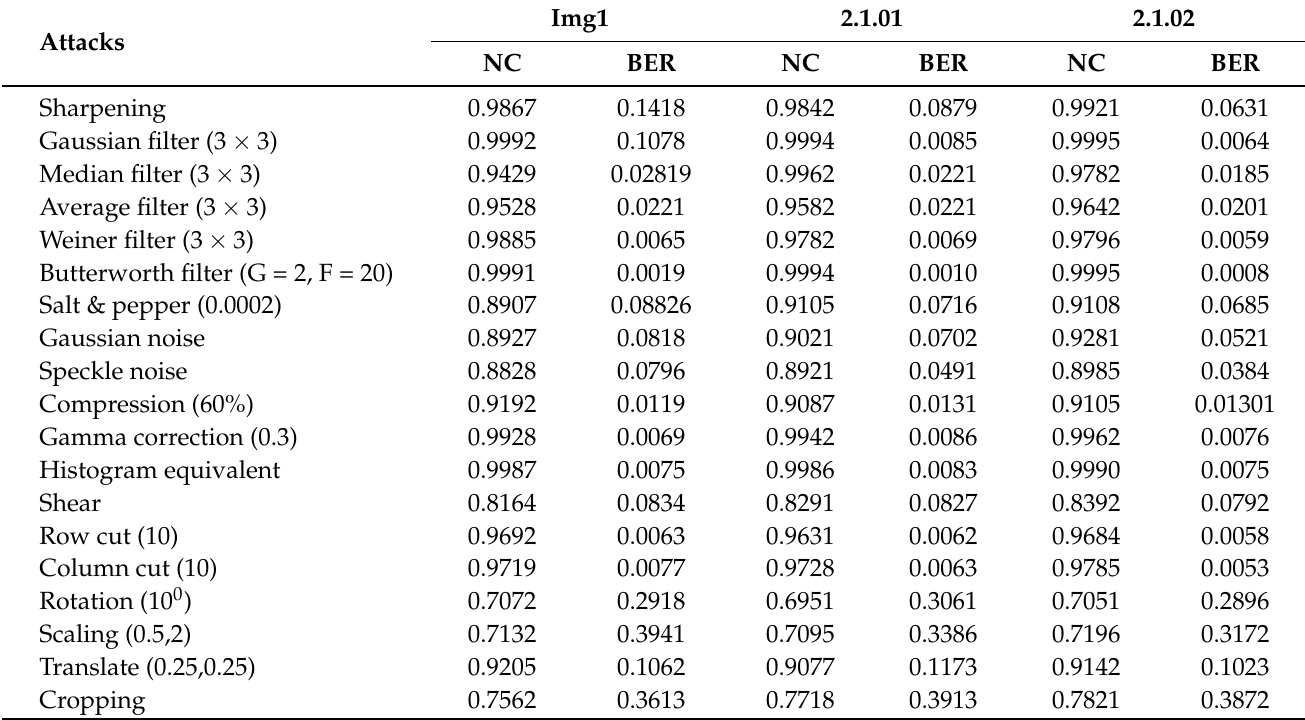
Table 7. NC and BER for aerial RS images (Img1, 2.1.01, and 2.1.02) taken from USC-SIPI [29] and Kaggle [30] datasets under attacks with optimized Γ using